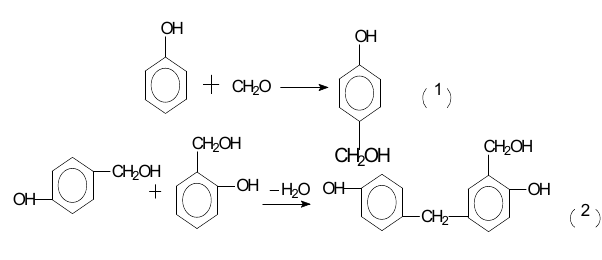
Figure 3. Synthesis scheme for phenolic resin.